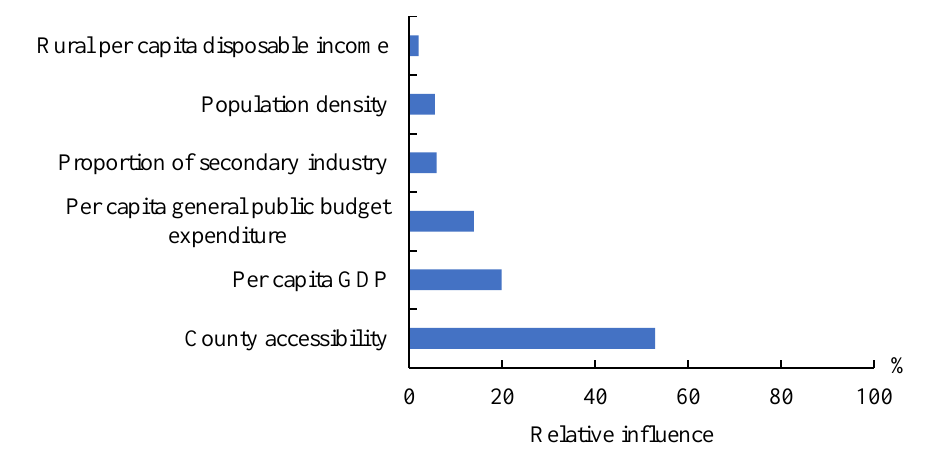
Figure 6. Variable interpretation degree diagram.